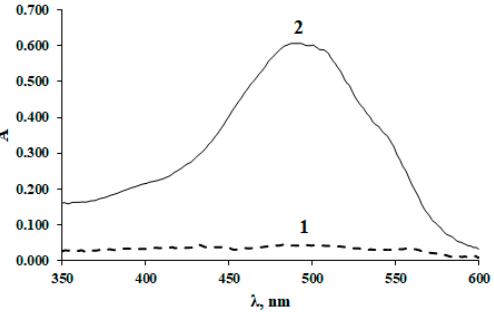
Figure 8. UV-vis spectrum of aqueous solutions as follows: (1) an amphiphilic copolymer of N -vinyl-2-pyrrolidone and allyl glycidyl ether; (2) an amphiphilic copolymer of N -vinyl-2-pyrrolidone and allyl glycidyl ether containing immobilized doxorubicin.